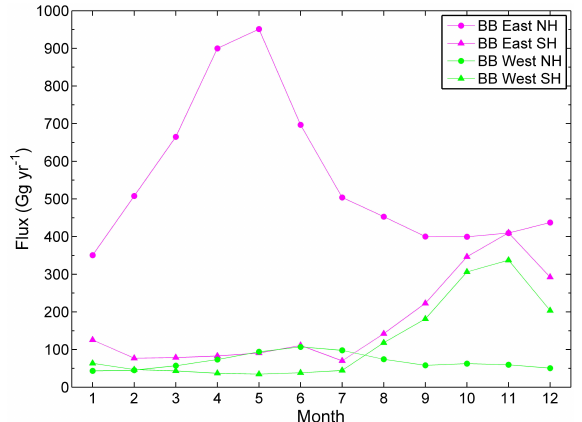
Fig. 10. Partitioning of the deduced average seasonal cycles of the Eastern and Western biomass burning sources into the Northern and Southern Hemispheres. Note the dominance of the Eastern North- ern Hemispheric emissions of CH 3 Cl. Also note the emission peaks of the Northern and Southern Hemispheres occur in the respective spring seasons consistent with dry conditions leading to increase biomass burning